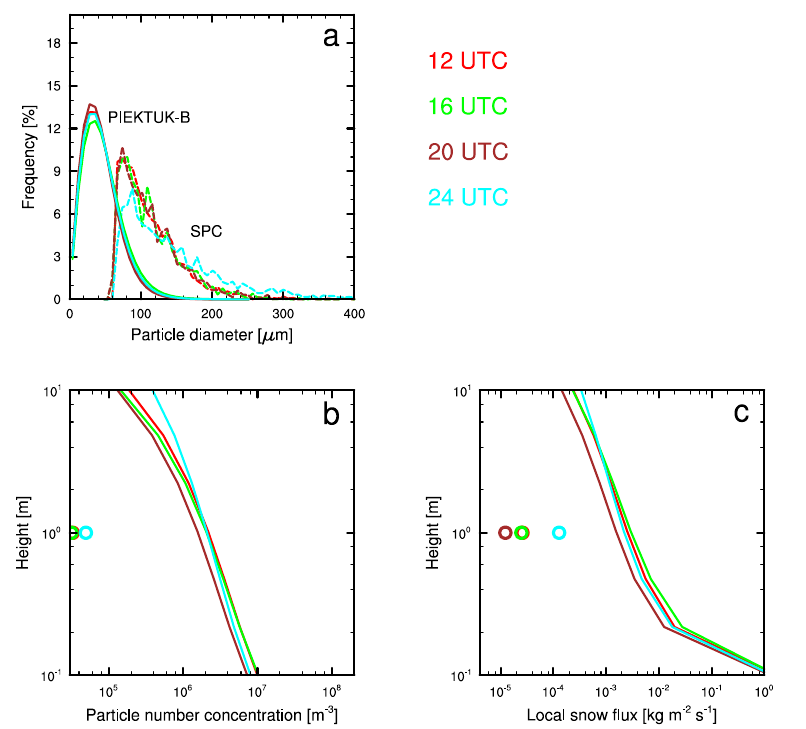
Fig. 10. Snapshots of drifting snow characteristics during 24 September 2012. (a) Relative frequency of drifting snow particle sizes at 1m above the surface according to PIEKTUK-B (solid lines) and observations (dotted lines); (b) and (c) vertical profiles of simulated particle concentration and horizontal snow flux (solid lines) and observed particle concentration and horizontal snow flux at ∼ 1m height (filled